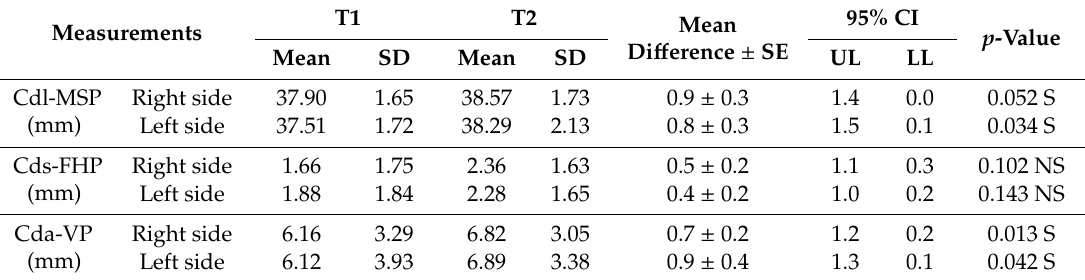
Table 5. Comparison of CBCT measurements (mm) of condylar position before and after twin block therapy in laser group ( n = 12) using paired t -test.